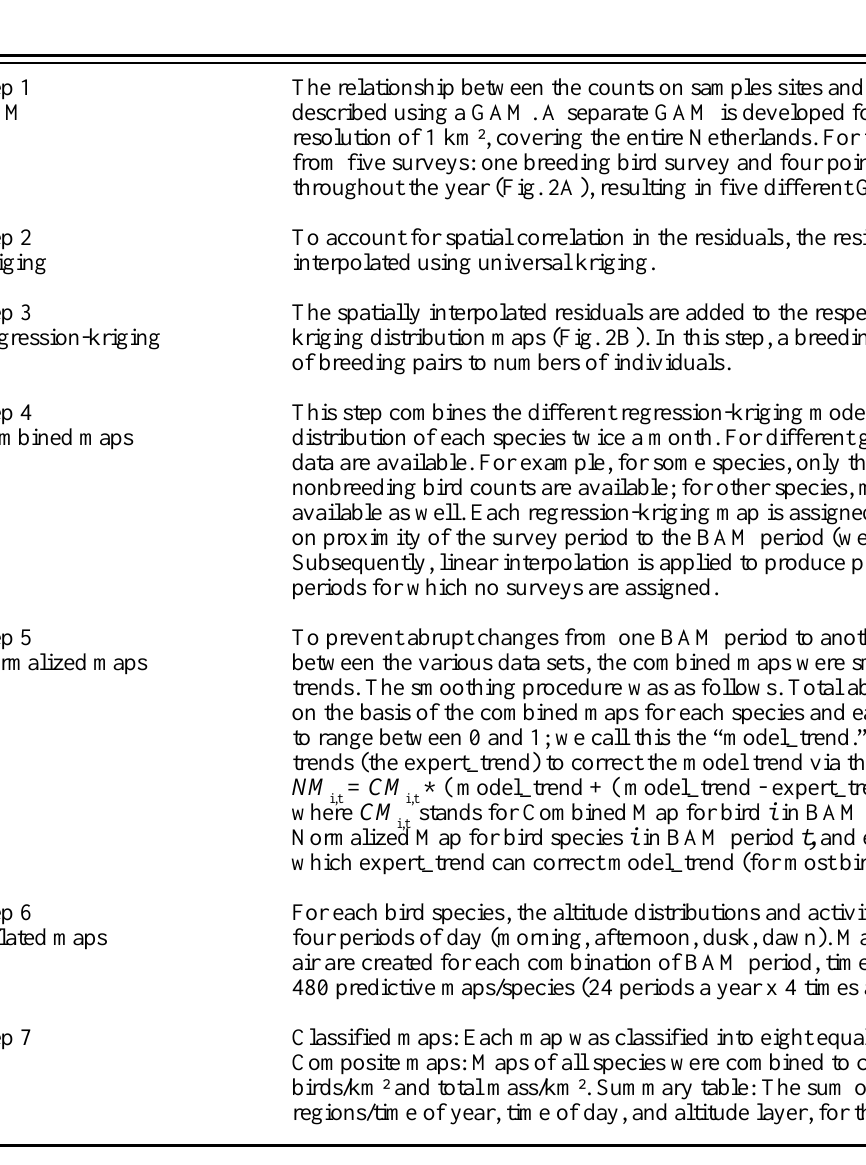
Table 1. A description of the Netherlands bird avoidance model workflow (Fig. 1) presented for a single species, the common buzzard ( Buteo buteo ). GAM stands for general additive regression model, and BAM for bird avoidance model.